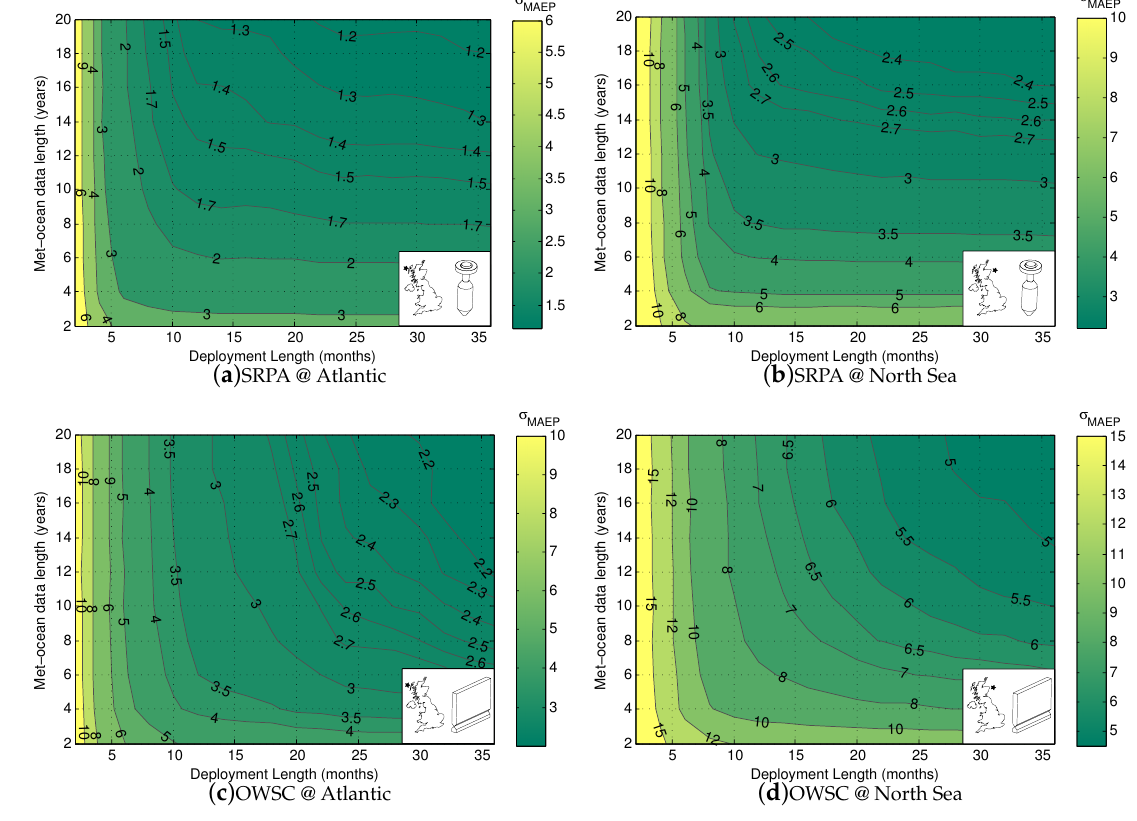
Figure 7. Contours of σ MAEP as a percentage of the ‘true’ MAEP as a function of historic met-ocean and WEC deployment data